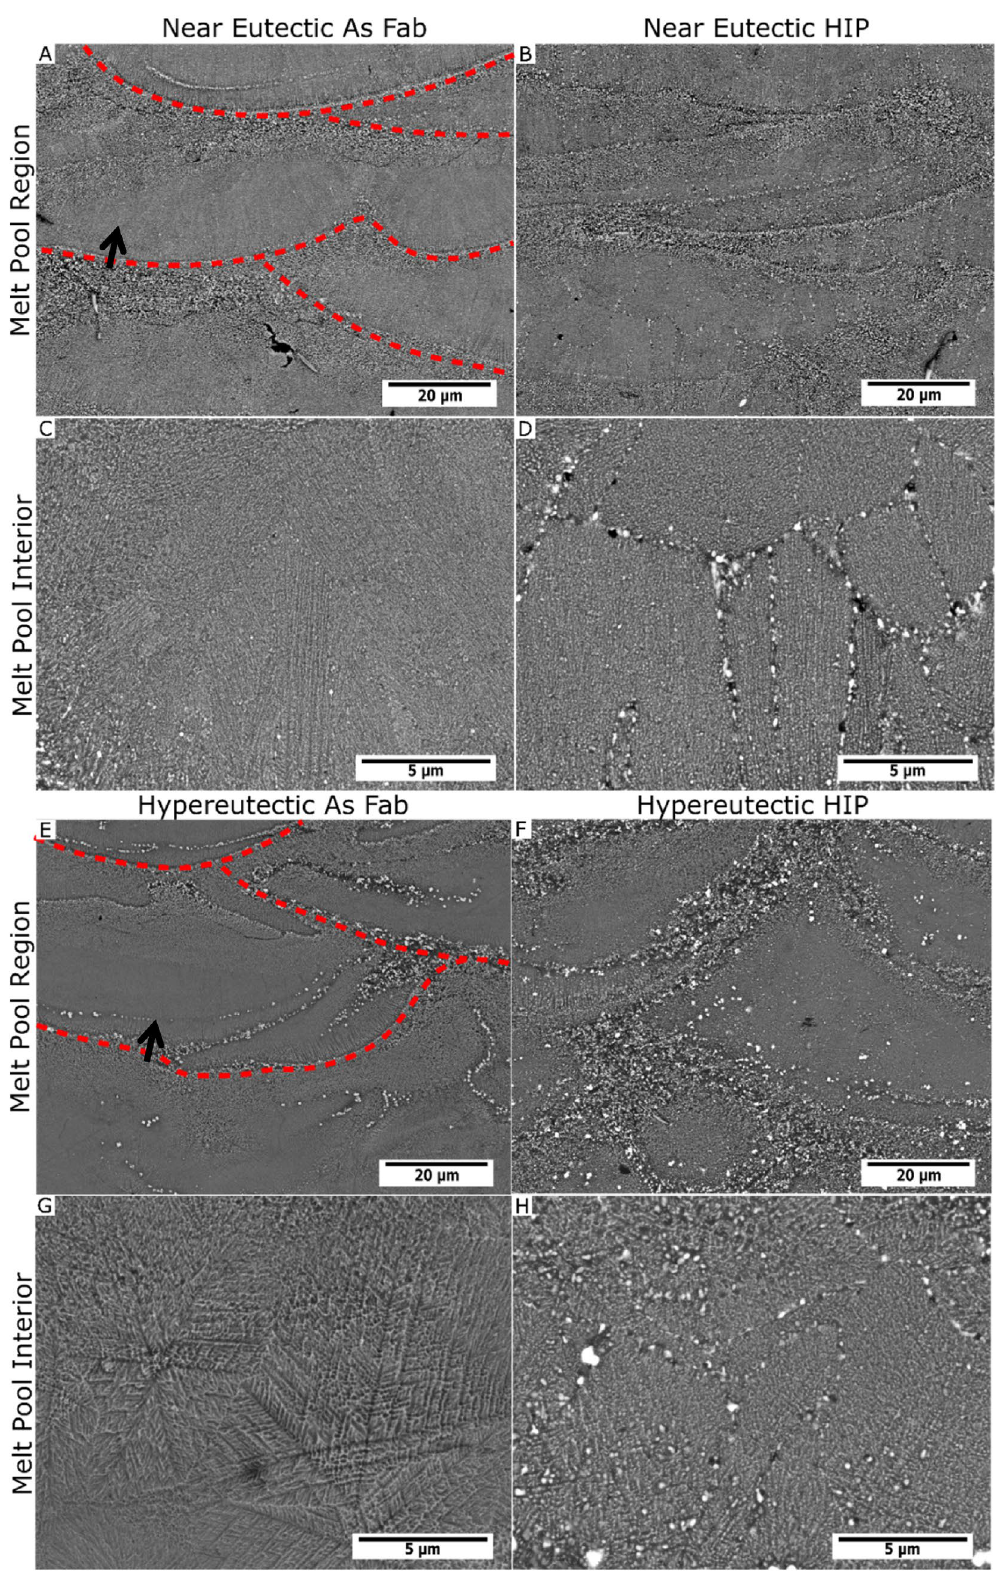
Figure 4. SEM of Selected Regions of Near Eutectic and Hypereutectic before and after HIP. Where ( A ) and ( C ) are the as fabricated Near Eutectic, ( B ) and ( D ) are the HIP Near Eutectic samples, ( E ) and ( G ) are the as fabricated Hypereutectic samples, and ( F ) and ( H ) are the HIP Hypereutectic